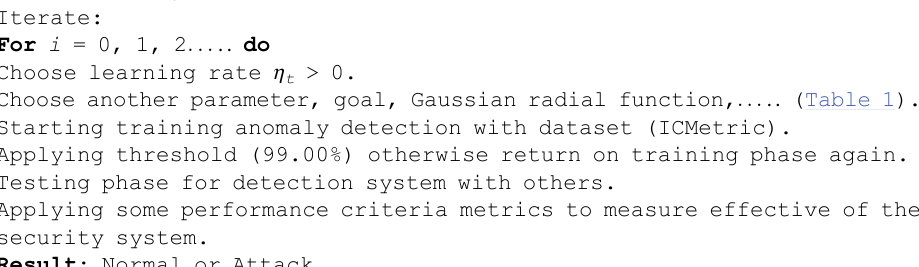
Algorithm 1 Deep Nural Network Algorithm